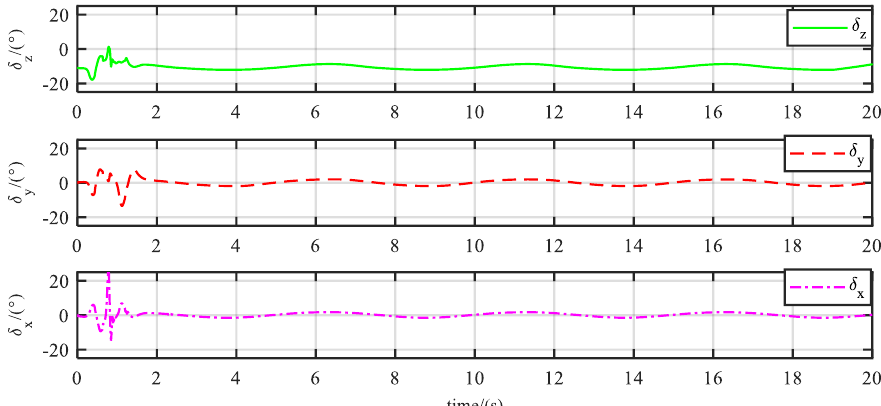
Figure 6. Control signals. It is worth noting that the equivalent surface of the pitch channel is initialized near the rough trim value of –11 degrees. If the trim value of your plant is close to 0, you can initialize it at 0 degrees.